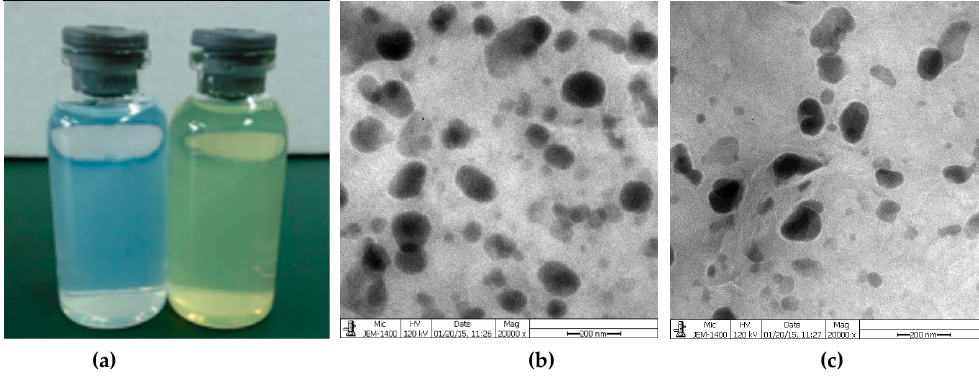
Figure 4. ( a ) Appearance of empty niosomes and quercetin-niosomes; ( b ) Transmission electron microscopy (TEM) image of blank niosomes; ( c ) TEM image of quercetin-niosomes.